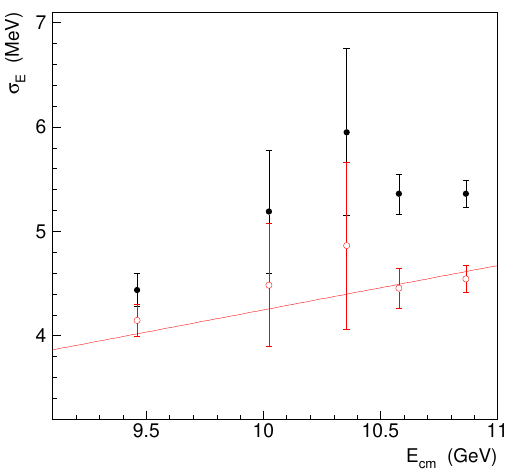
Figure 6 . Energy dependence of the E cm spread. Black dots with error bars are the measurements, red open dots are σ E corrected for the microwave instability effect, red line is the fit cm